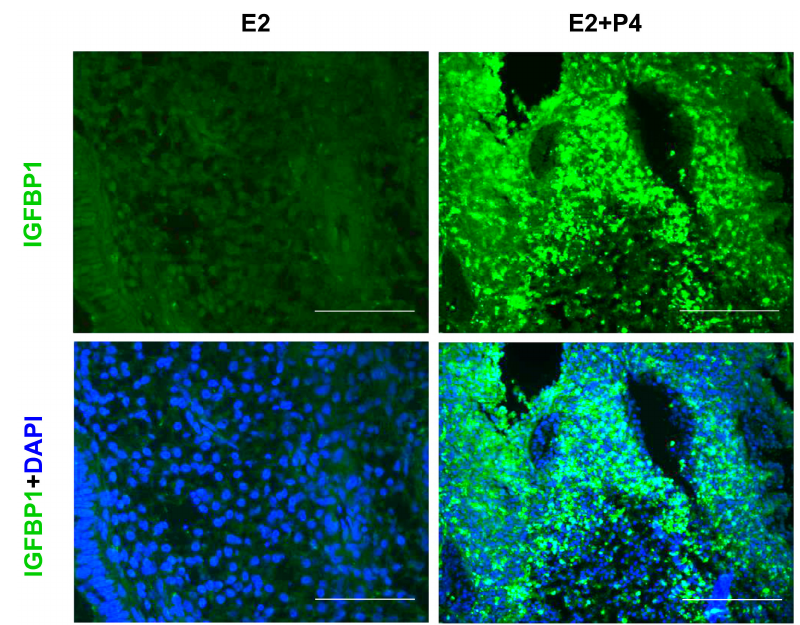
Figure 8. Decidual induction of Insulin-like Growth Factor Binding Protein 1 (IGFBP1) expression in the endometrial slices after the 21-day culture period. IGFBP1 immunofluorescence staining (green signals) in tissue sections derived from the endometrial slices in 3D culture treated with 4 days of E2 + P4. Nuclei were counterstained with 4 (cid:48) , 6-diamidino-2-phenylindole (DAPI). Scale bar 200 µ m; Original magnification 160 ×